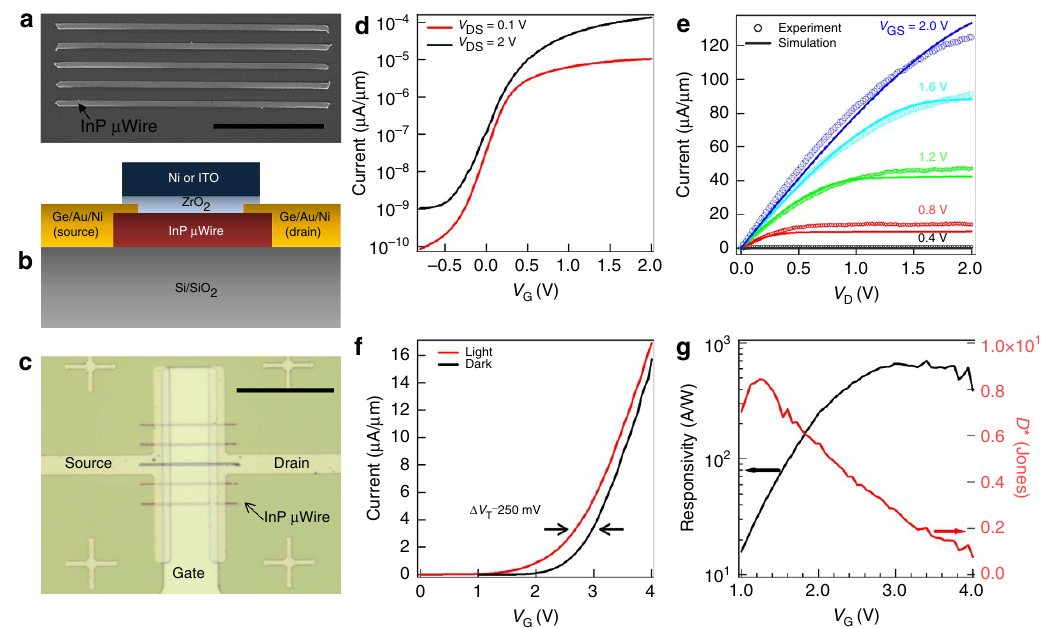
Figure 4 | Electronic characterization. ( a ) An SEM image of typical 1- m m wide InP m Wires used for MOSFET fabrication. Scale bar, 20 m m. ( b ) A cross-sectional schematic of the InP MOSFETs along with ( c ) an optical image of a MOSFETwith 5 m wires as the channel. Scale bar, 50 m m. ( d ) The transfer I DS - V GS and ( e ) output I DS - V DS curves of an InP transistor with a single m Wire as the channel and a 3 m m gate length. ( f ) The transfer characteristics of a photo-MOSFET in dark and exposed to 15.6mWcm (cid:3) 2 of light, showing a large threshold voltage shift of B 250mV. ( g ) The responsivity and detectivity of the photo-MOSFET are plotted versus the gate voltage